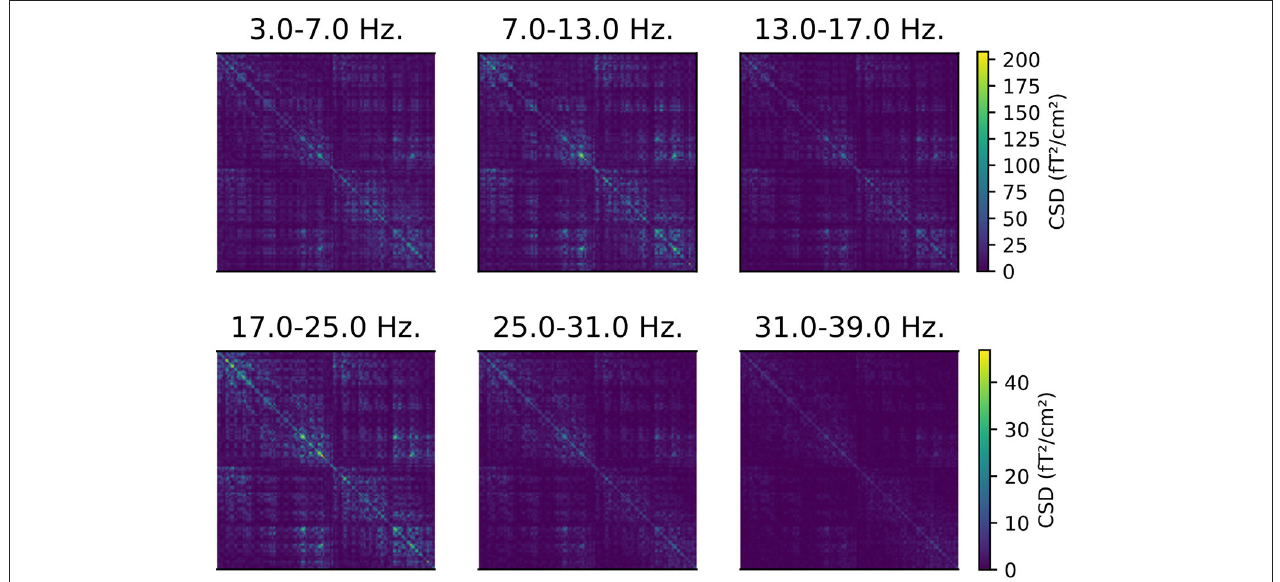
FIGURE 1 | CSD matrices computed for different frequency bands. The CSD matrices were computed across all the epochs where a face stimulus was presented to subject 2, in the time window from 0 to 0.4 s relative to the presentation of the stimulus. Each row and column corresponds to one of the 204 gradiometers. Note that each row has a separate color scale.